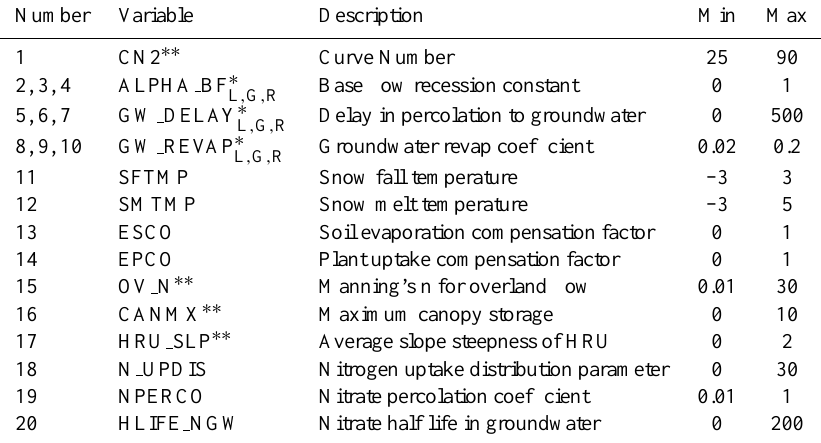
Table 1. SWAT Parameters used for automated